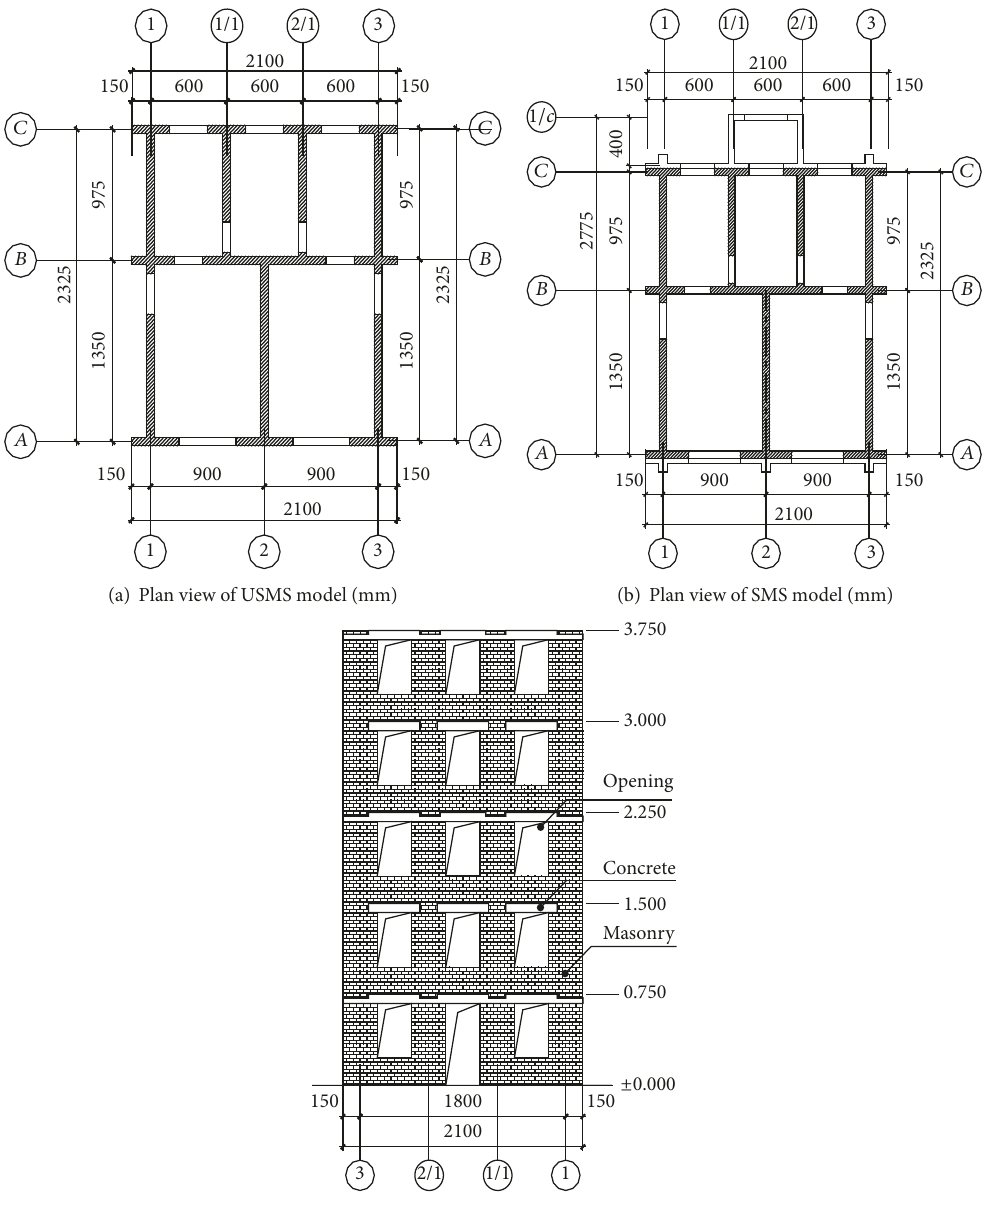
Figure 2: Plan views and elevation view of experimental